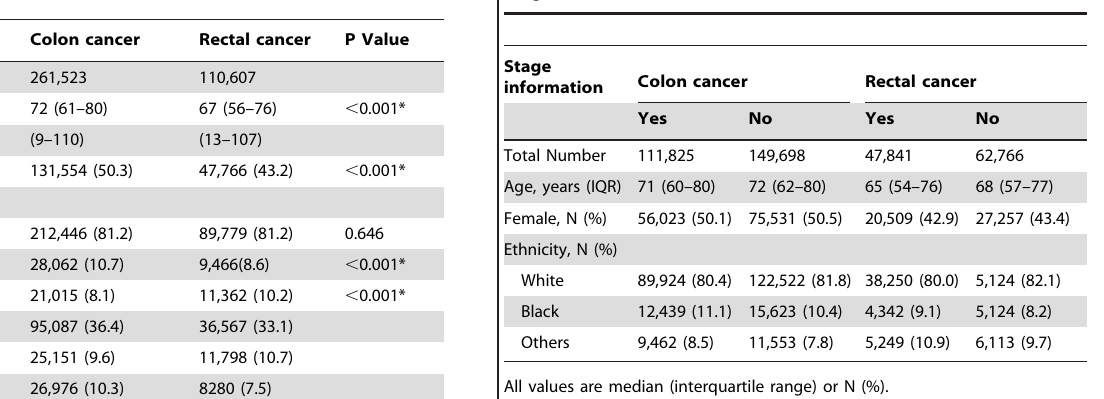
Table 1. Characteristics of all subjects.